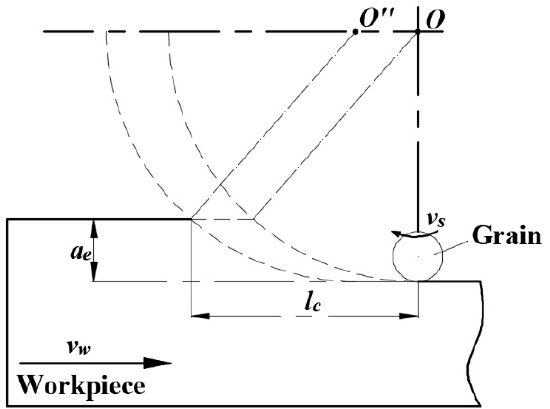
Figure 1. The material removal process of a single abrasive particle.